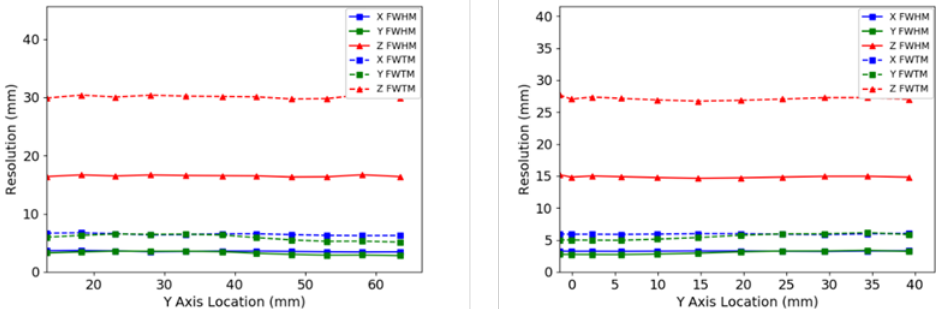
Figure 6. System spatial resolutions produced with a back-projection reconstruction. Left: the central Z-axis resolution plotted as a function of point-source location along the X-axis. Right: the quarter of the Z-axis resolution plotted as a function of point-source location along the X-axis. The reconstructed image of the micro hotspot phantom presented in Figure 7 demon- strates the visualization of small sources down to the 1.35 mm-diameter rods while using the MLEM reconstruction and down to the 1.7 mm-diameter rods with the back-projection reconstruction. As expected, MLEM-reconstructed images exhibited less noise and better image contrast.